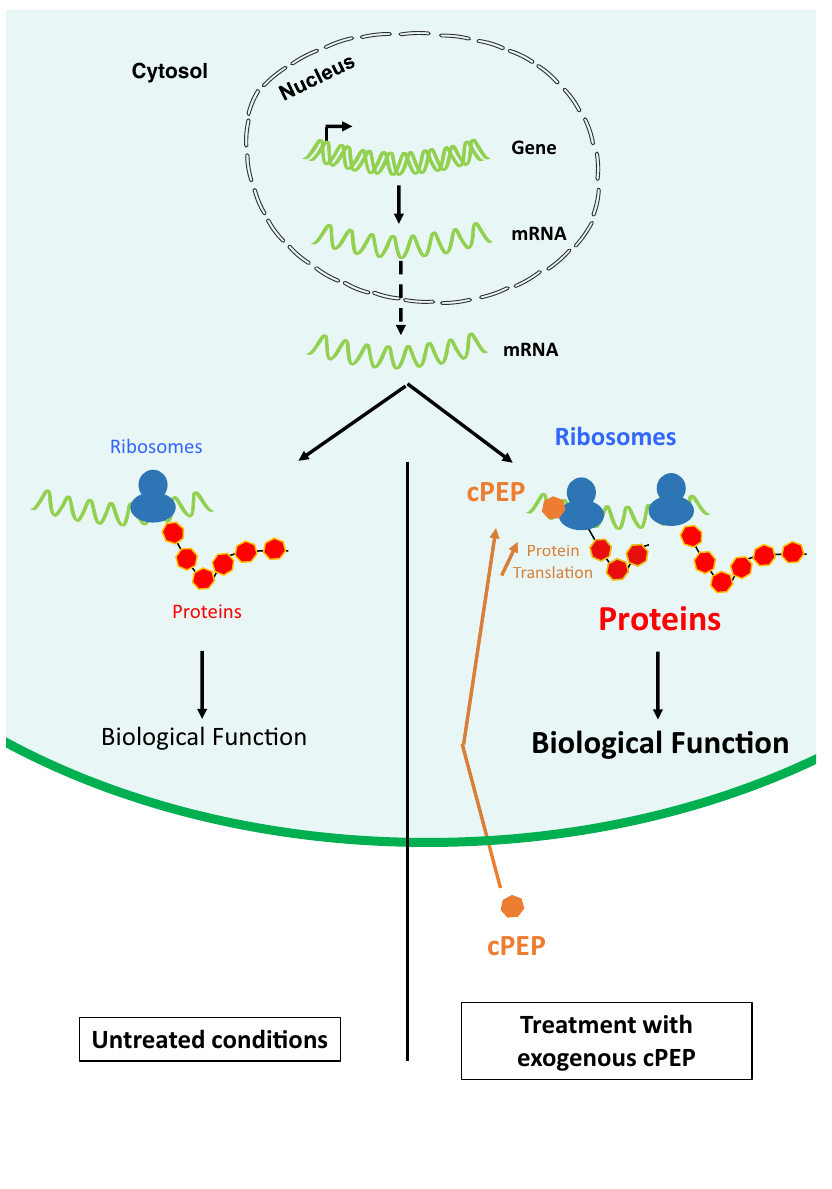
Fig. 6 | Schematic representation of the mode of action of cPEPs. cPEPs exo- genously applied on plants penetrate plant cells and interact with their own RNA and ribosomes to improve their recruitment and increase the translation of